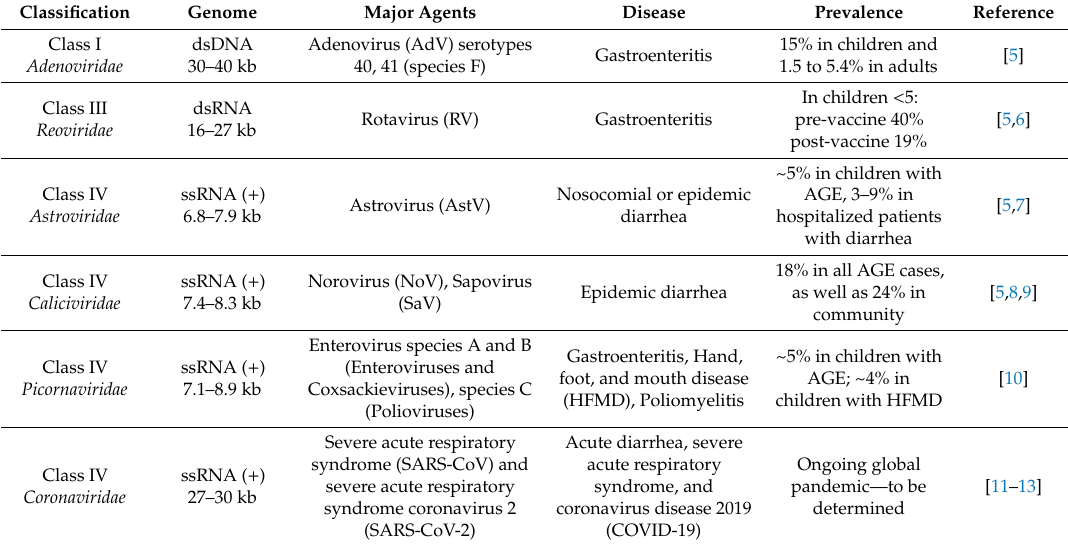
Table 1. Summary of major enteric viral pathogens, many of which have been frequently implicated in virus–virus co-infection